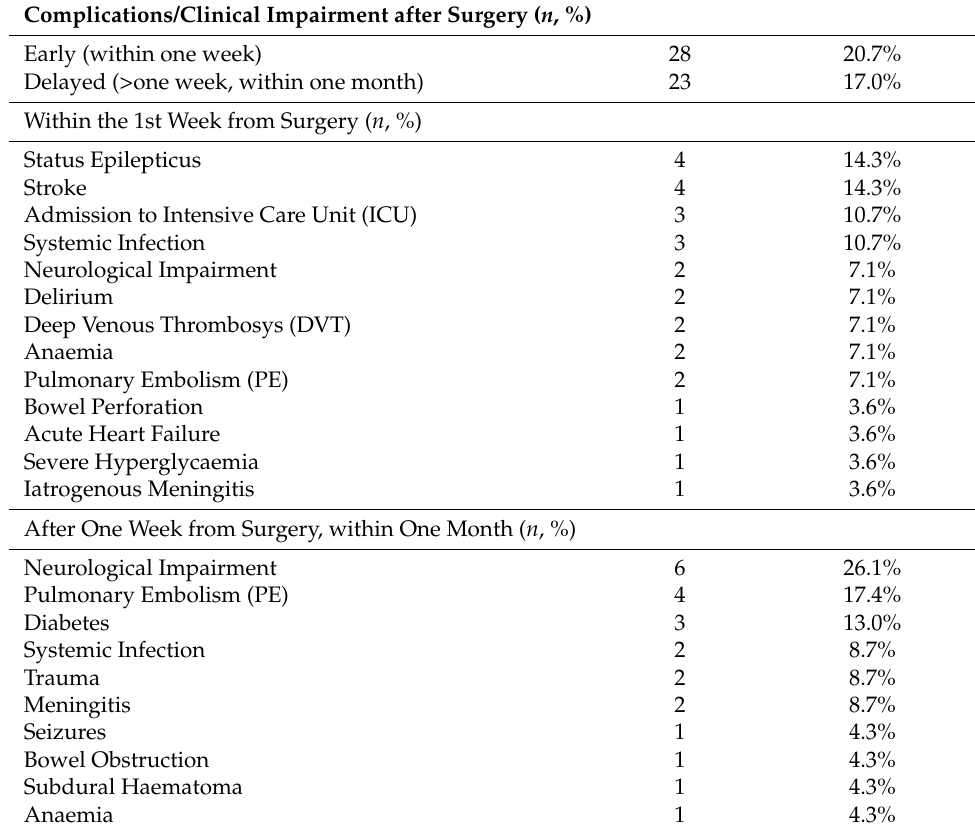
Table 2. Clinical Complications within One Month from Surgery.